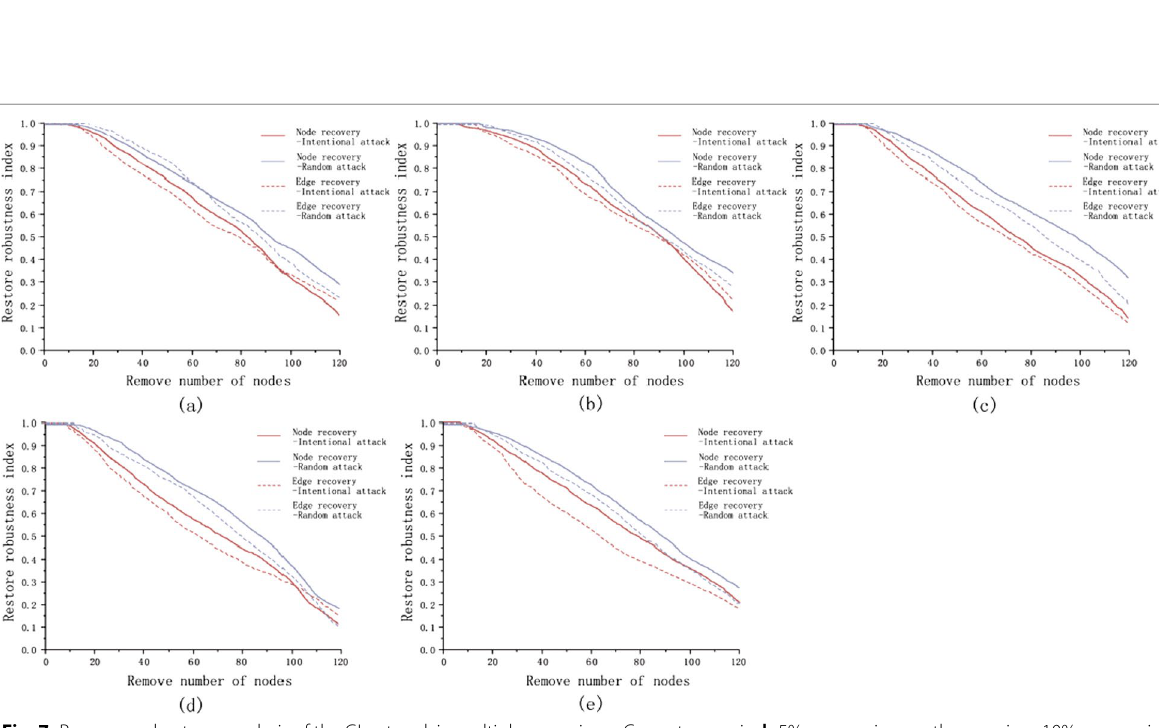
Fig. 7 Recovery robustness analysis of the GI network in multiple scenarios. a Current scenario, b 5% economic growth scenario, c 10% economic growth scenario, d 15% economic growth scenario, e 20% economic growth